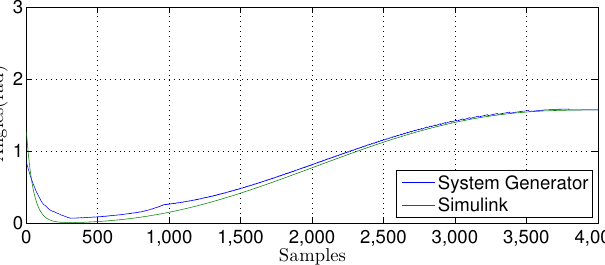
Figure 33. Comparison of the simulation results in Matlab Simulink and system generator for the MLP-BP using W = 12.